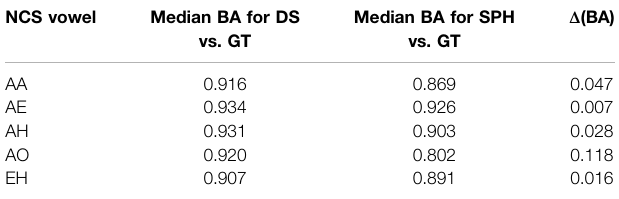
TABLE 3 | Bhattacharyya ’ s Af fi nity for DeepSpeech versus ground truth and Sphinx versus ground truth in Inland Northern speakers. BA score 1.0 (cid:1) perfectly overlapping distributions, 0.0 (cid:1) completely non-overlapping.